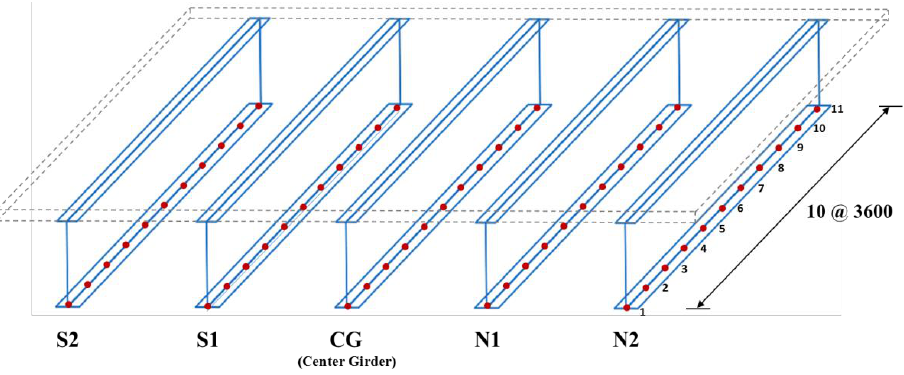
Figure 10. Measurement points on the girder (Unit: mm). Table 5. The number of training and test datasets.